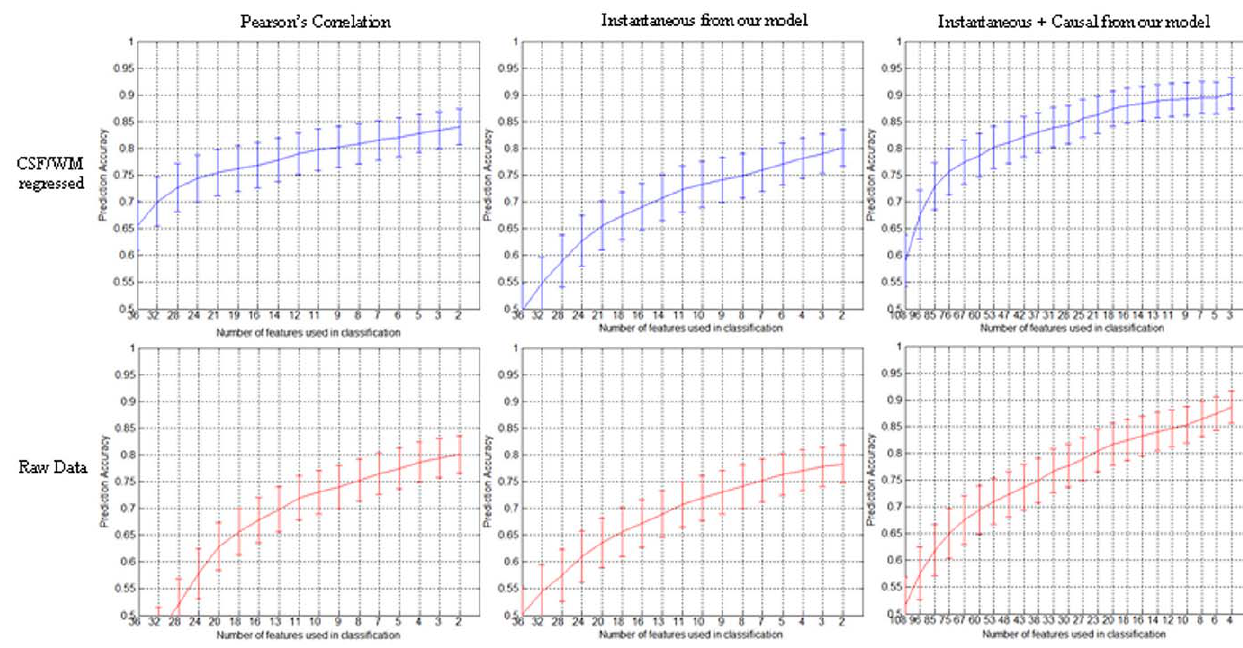
Figure 3. The evolving performance of the RCE-SVM classifier with decreasing number of features derived from: top row – data regressed with CSF and white matter time series, bottom row – data not regressed with CSF/WM time series, left column – Pearson’s correlation from resting data, middle column – instantaneous influence from our model from resting data, right column – instantaneous and causal influence from our model from resting data.